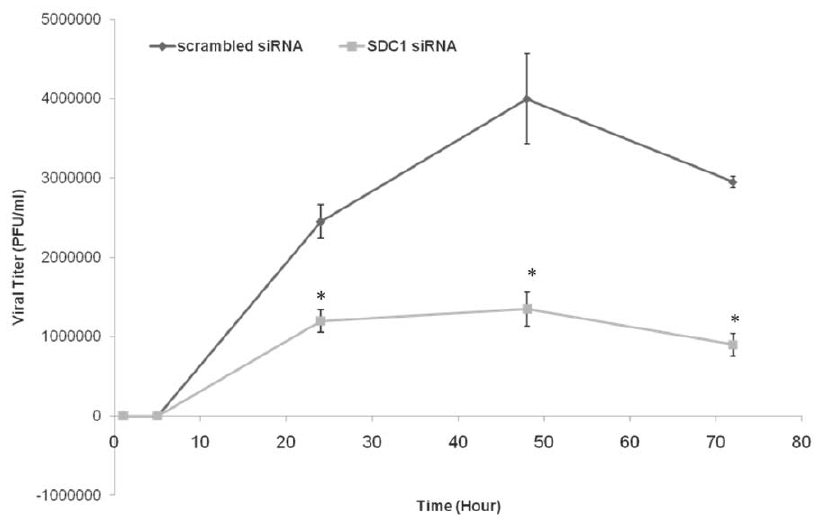
Figure 8. Downregulation of Syndecan-1 results in reduced production of infectious virus. HCE cells were transfected with either control scrambled siRNA or syndecan-1 siRNA. 72 h post-transfection cells were infected with HSV-1 (KOS) at an MOI of 0.1. At 0, 5, 24, 48, and 72 h post- infection, infectious virus was quantified by a standard plaque assay on HCE cell monolayers. The titers shown are the mean 6 1 SD of a representative experiment of two independent experiments performed in duplicates. SDC1 ,